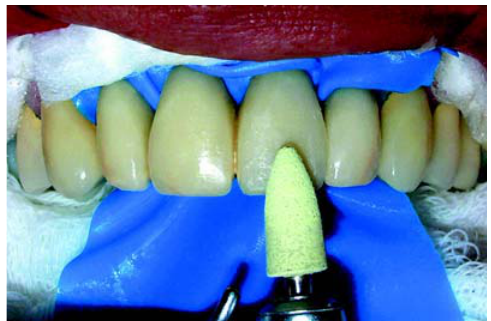
FIGURE 7- Finishing of the restoration